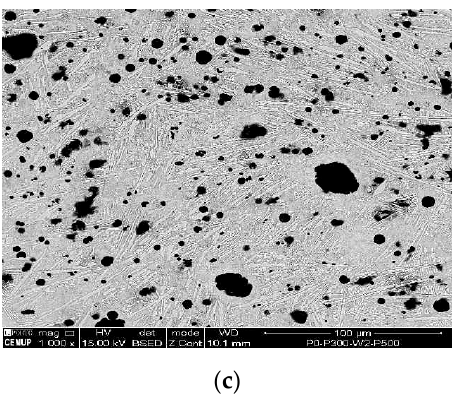
Figure 5 . SEM analysis of the experimental samples etched with 4% Nital and 1000× magnification: ( a ) sample 1P0W2P400 (UTS 390.0 MPa), ( b ) sample 2P300W2P300 (UTS 394.2 MPa), and ( c ) sample